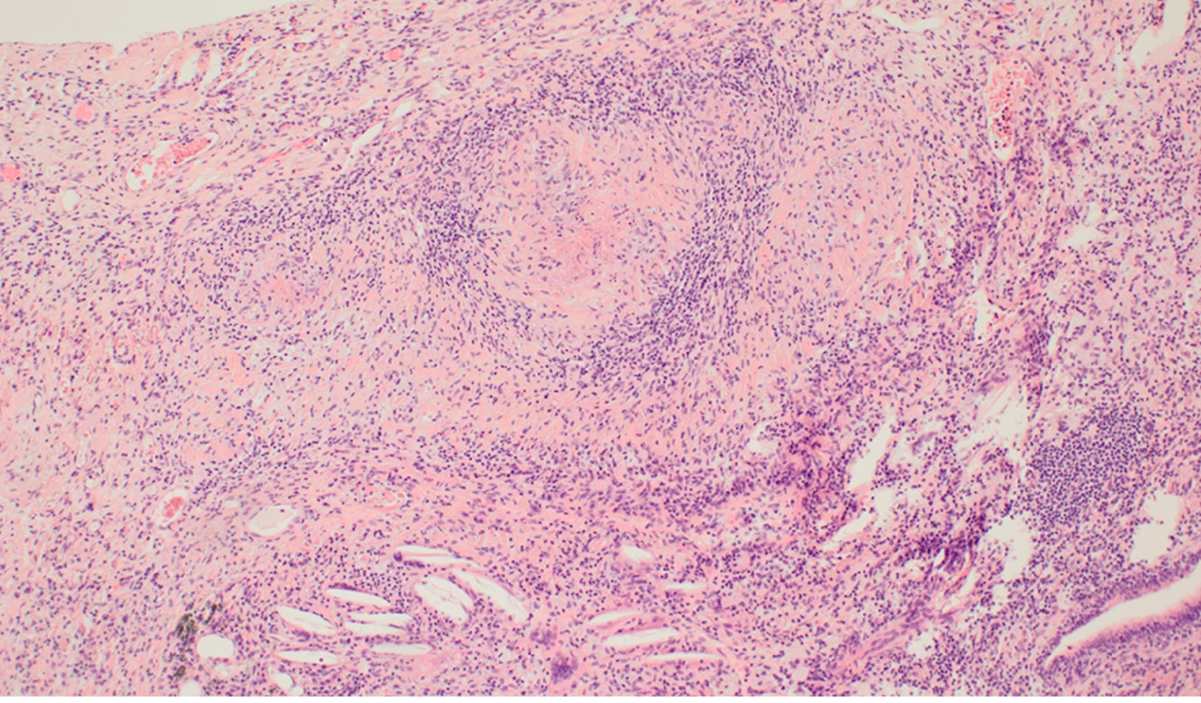
Figure 5. VATS biopsy from the right lung’s middle lobe: GPA blood vessels with vasculitis: destruction of larger vessel walls and lumina due to inflammation. Magnification: ×10. HE stain.